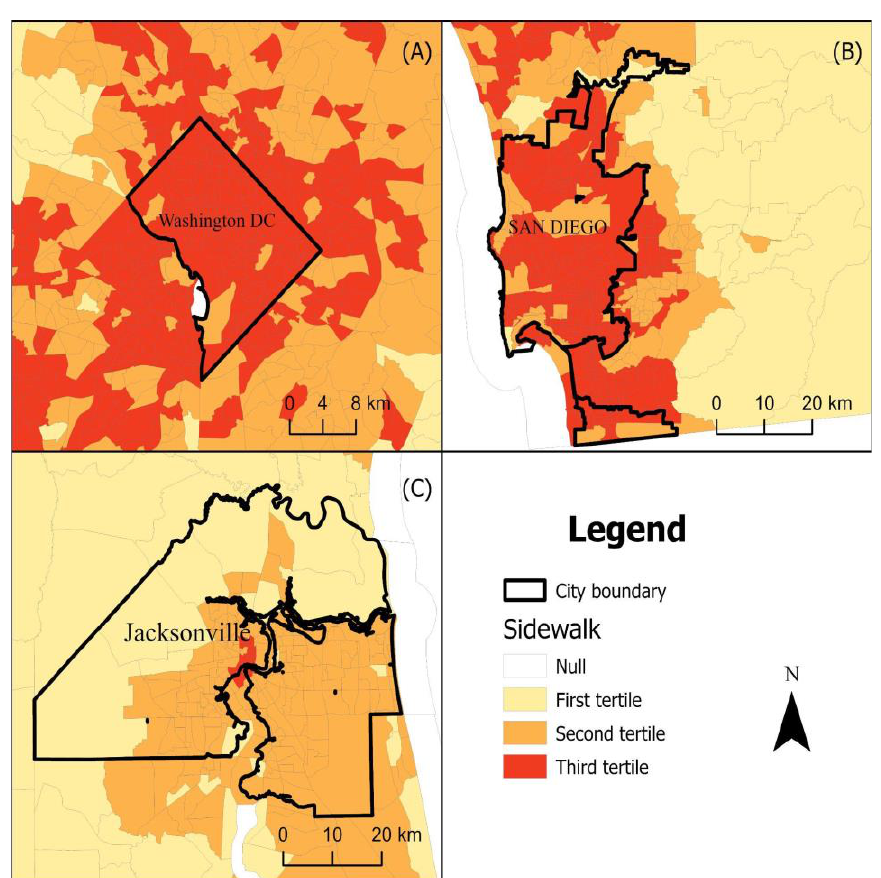
Figure 4 . Census tract level distribution of GSV-derived neighborhood characteristics. (a) non- single family home, (b) street light, (c) street sign, (d) two or more cars. Darker colors signal higher prevalence of a neighborhood characteristic.